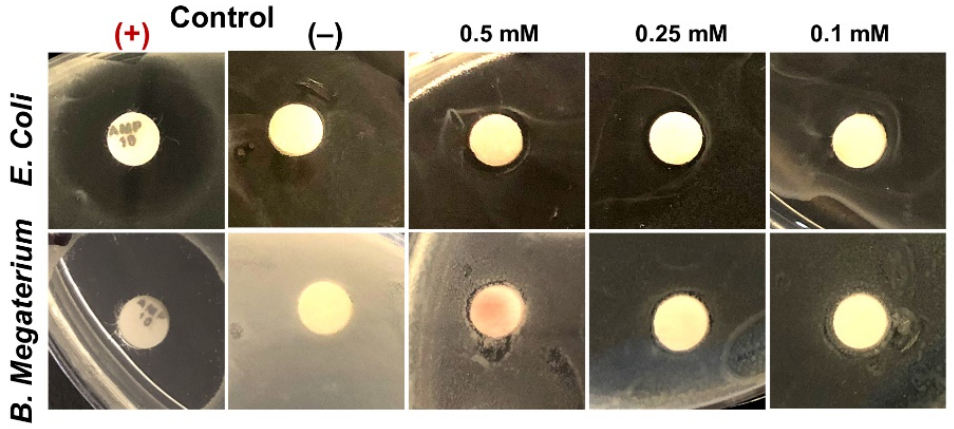
Figure 7. Antimicrobial testing results: top: E. coli and bottom: B. megaterium . The ampicillin and blank discs were used as positive and negative control,